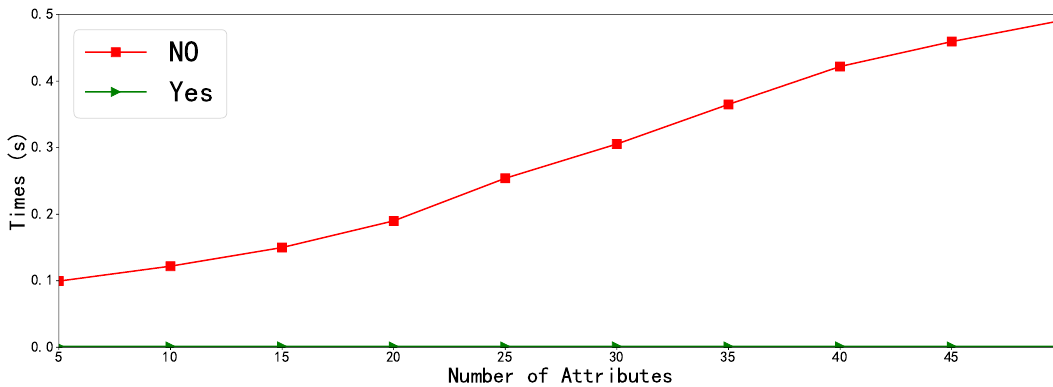
Figure 2. Comparison of outsourcing and non-outsourcing of our scheme, where “Yes” represents our scheme with outsourcing and “No” represents our scheme without